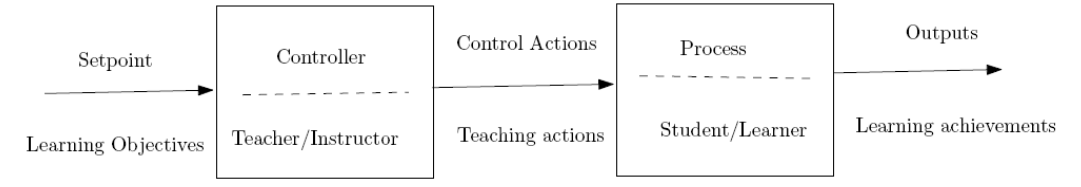
Fig. 2: Open-loop instructional/control